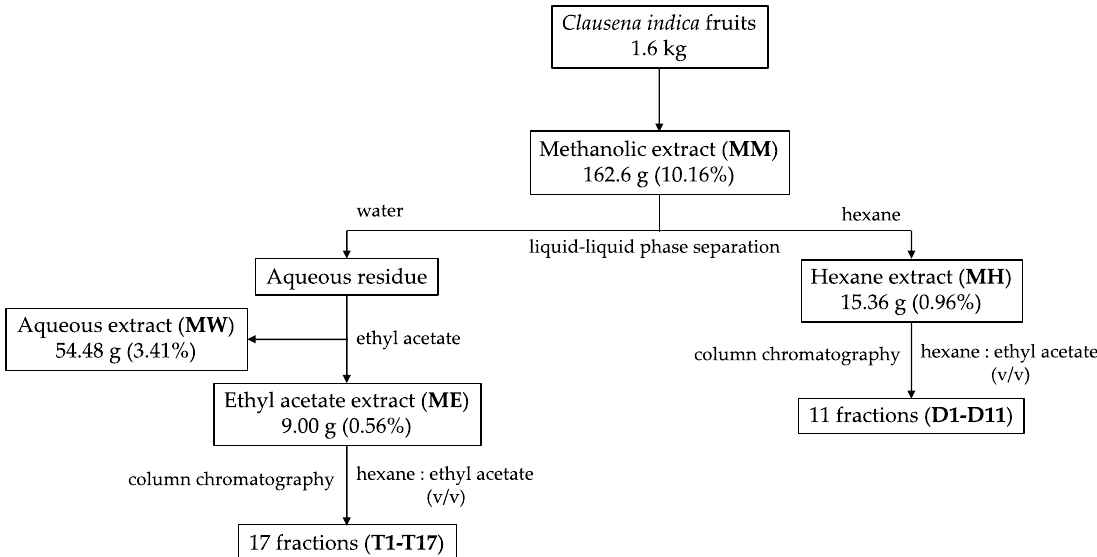
Figure 1. Extraction and isolation procedure of bioactive constituents from C. indica fruit.